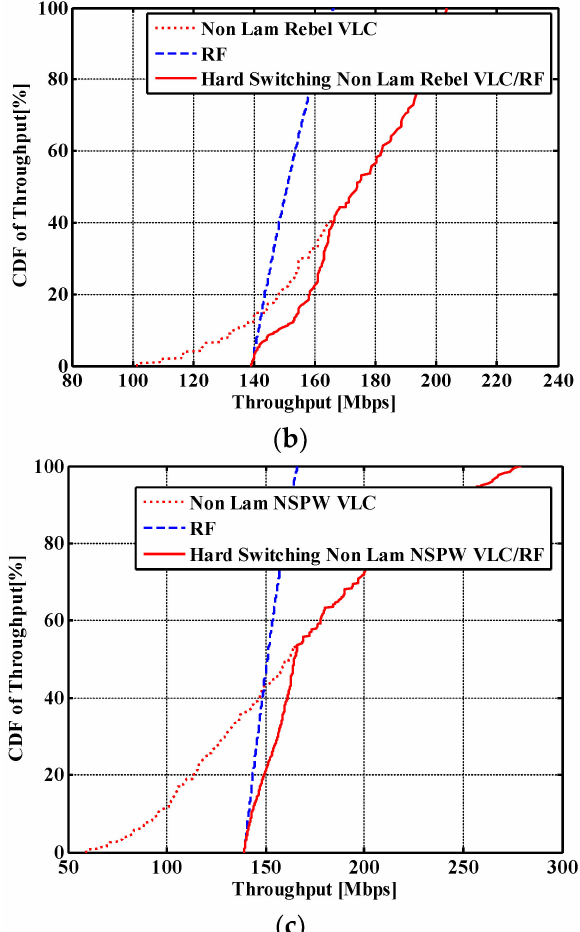
Figure 11. CDFs of hybrid VLC/RF link throughput spatial distribution for ( a ) Lambertian optical beam configuration, ( b ) LUXEON Rebel optical beam configuration, and ( c ) asymmetric NSPW optical beam configuration.